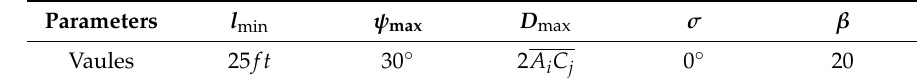
Figure 7. Diagram of experiment model. Table 2. Parameters setting in the experiment.